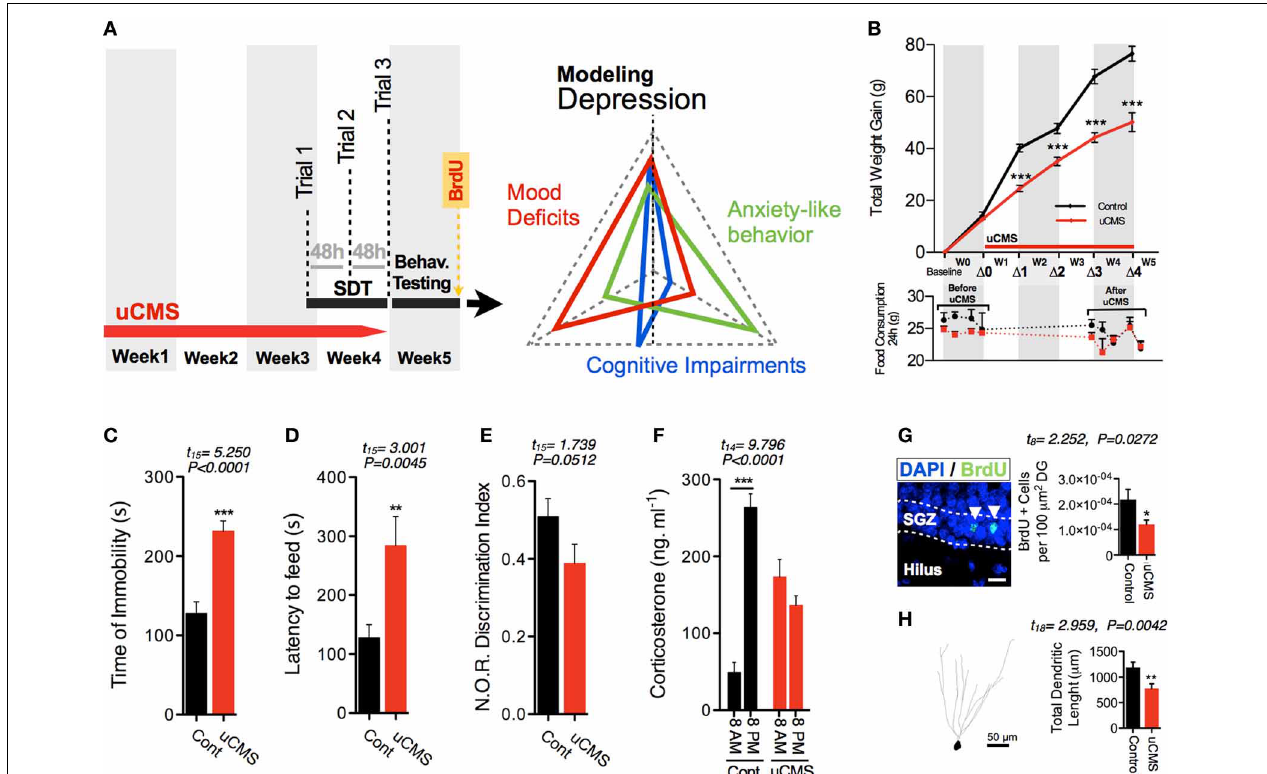
P < 0 . 0001]. Daily food consumption of uCMS animals remained unaltered after stress exposure. Animals were tested in the Forced Swimming Test (C) , Novelty Suppressed Feeding (D) and Novel Object Recognition (E) test paradigms. ∗ P < 0 . 05, ∗∗ P < 0 . 01, ∗∗∗ P < 0 . 001. Error bars, s.e.m., n = 8–10. (F–H) Corticosterone serum levels (F) , hippocampal proliferation (G) and dendritic morphology of hippocampal granular neurons (H) were